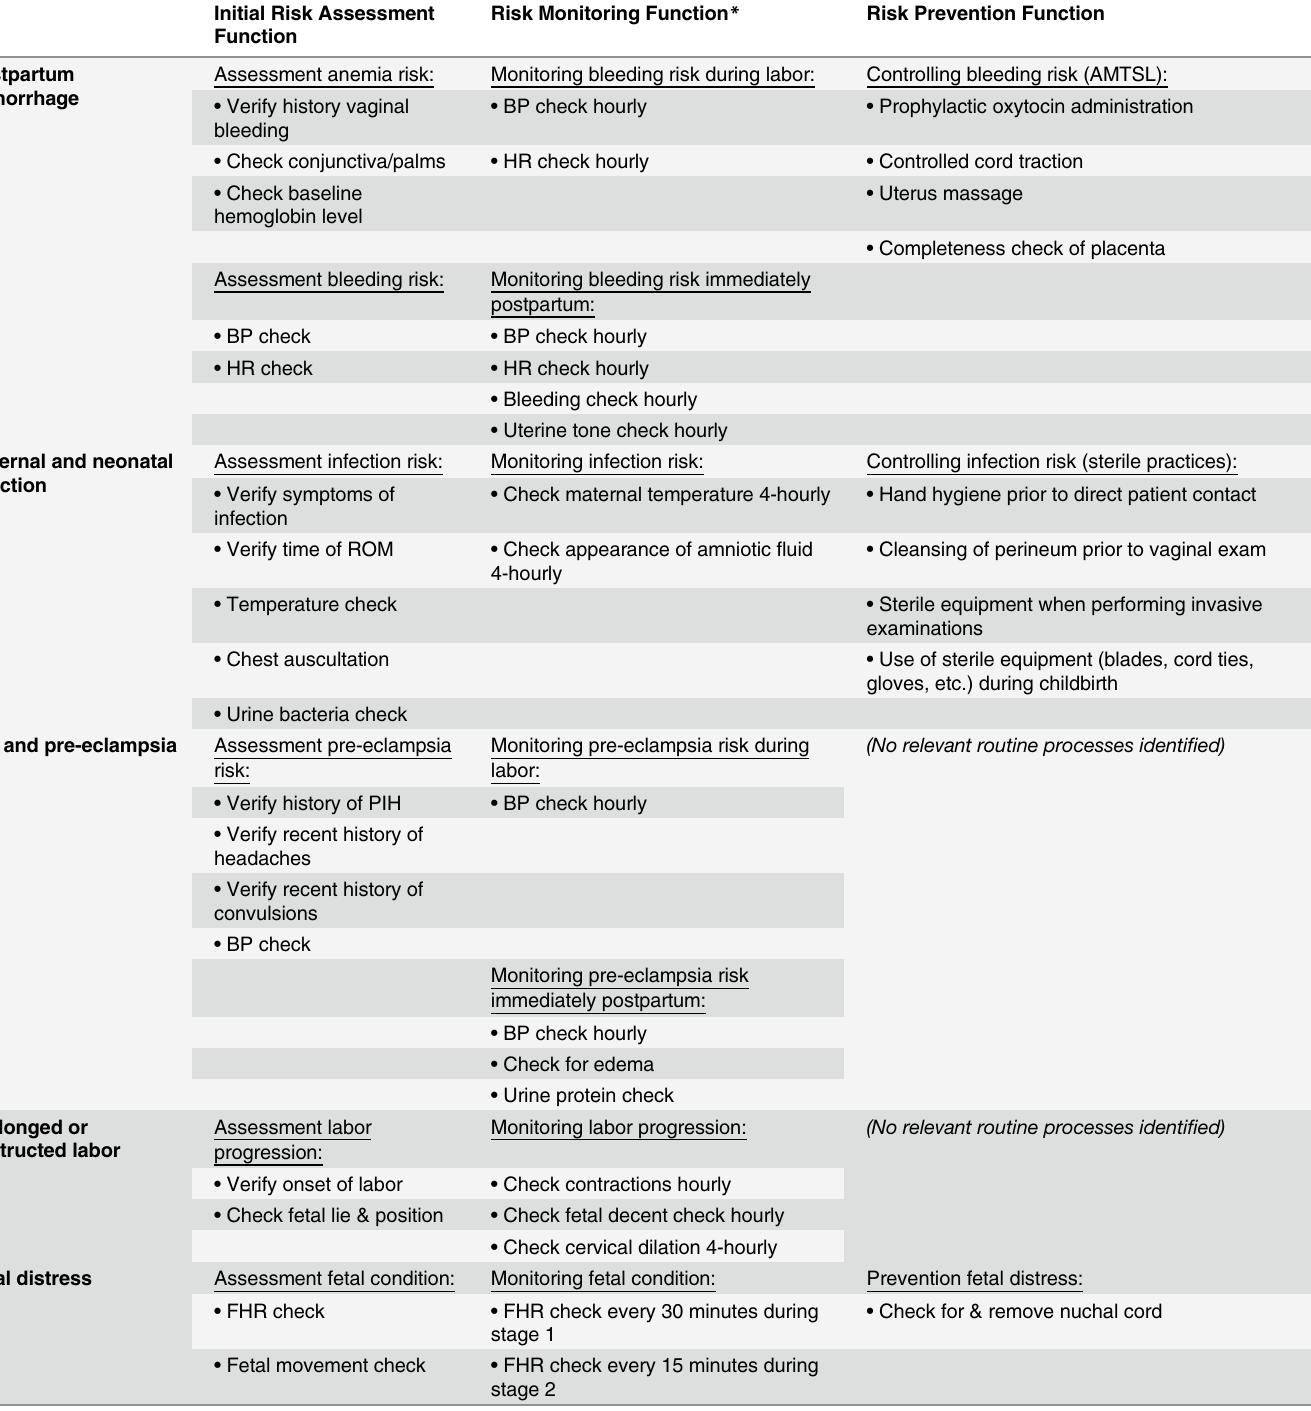
Table 1. Final set of routine care process indicators by clinical core functions and major obstetric and neonatal